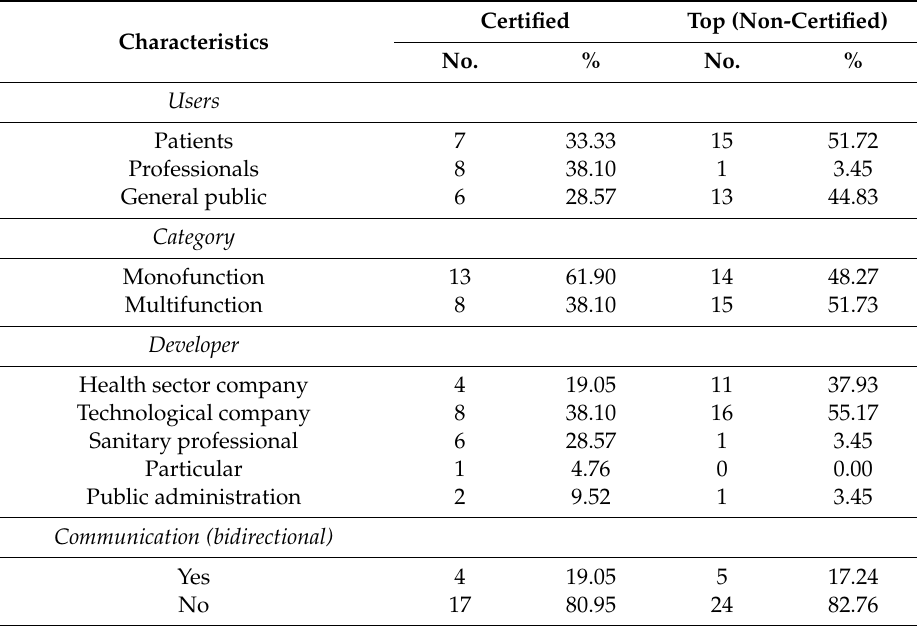
Table 2. Details of h-apps ( n = 50)